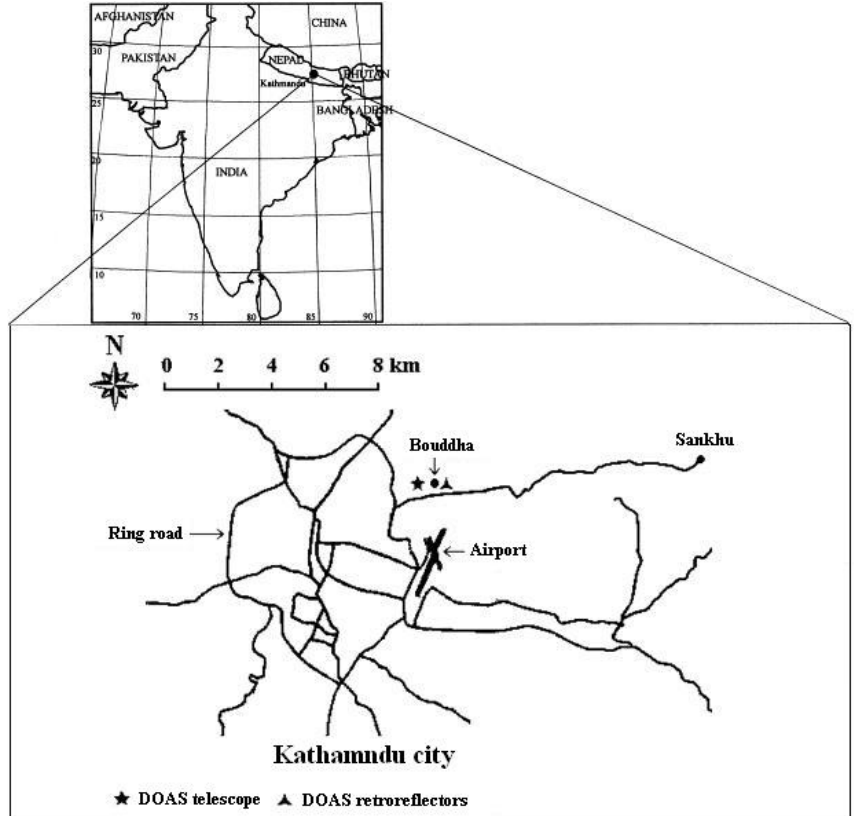
Fig.1 Fig. 1. Map of Kathmandu showing the measurement